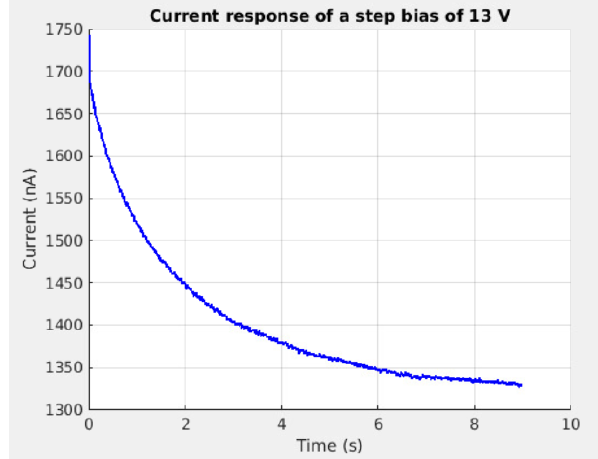
Figure 17. Current response to a 13V